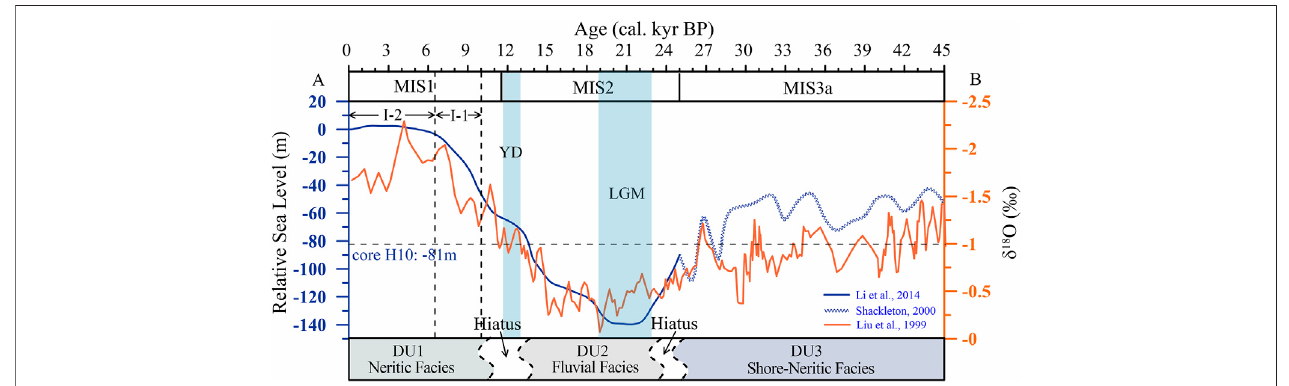
FIGURE 8 | Changes of the relative sea-level (RSL) (A) and oxygen isotope ( δ 18 O) (B) since Marine Isotope Stage 3a (MIS3a).